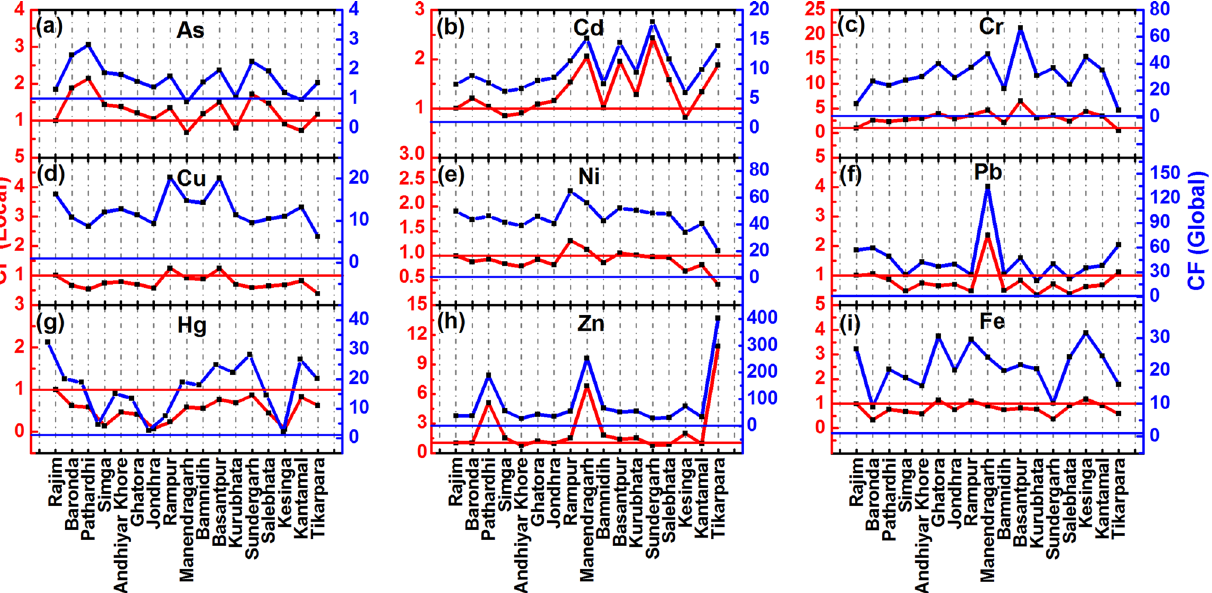
Fig. 4 Contamination factor of the dissolved trace metals of Mahanadi River and its tributaries with respect to local as well as global background